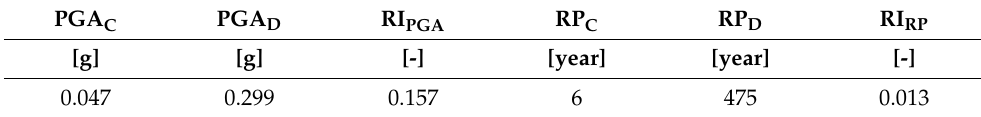
Table 3. Risk indices obtained from pushover analysis (current configuration).